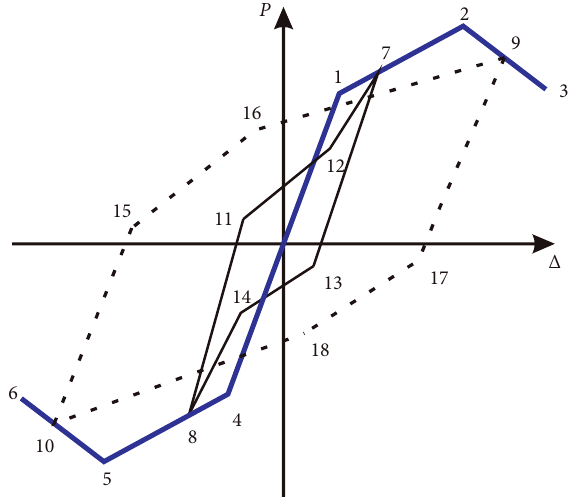
Figure 20: Restoring force model of the energy-dissipation joint in a steel-engineered bamboo hybrid